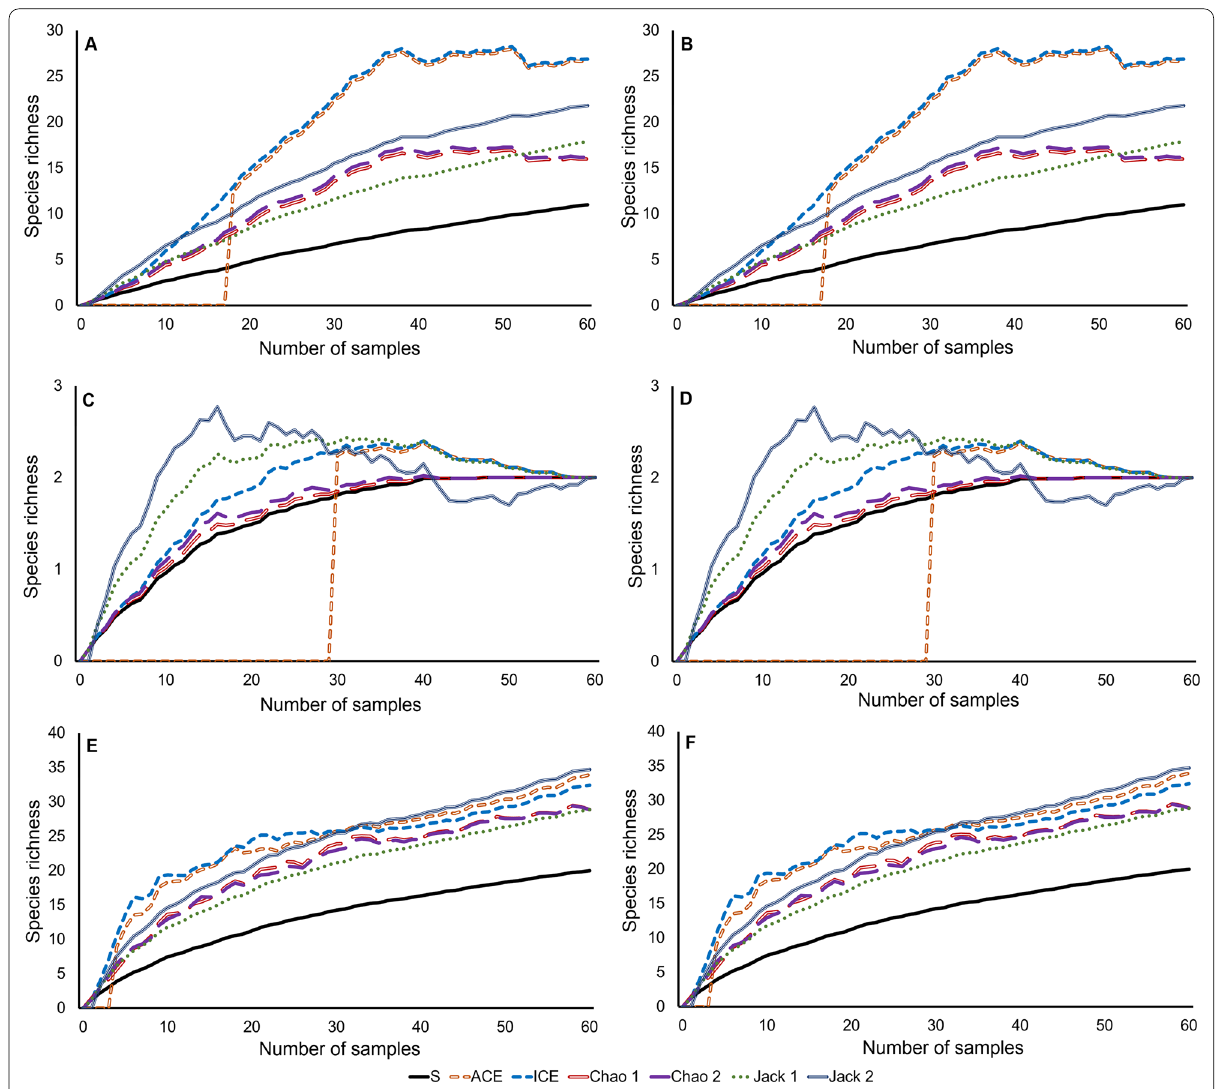
Fig. 3 Species richness estimation curves for Chaco National Park, Chaco, Argentina, with adult data. A , B : foliage, C , D : leaf litter, E , F : grassland; A – C – E : analyses with HTS; B – D – F : analyses without